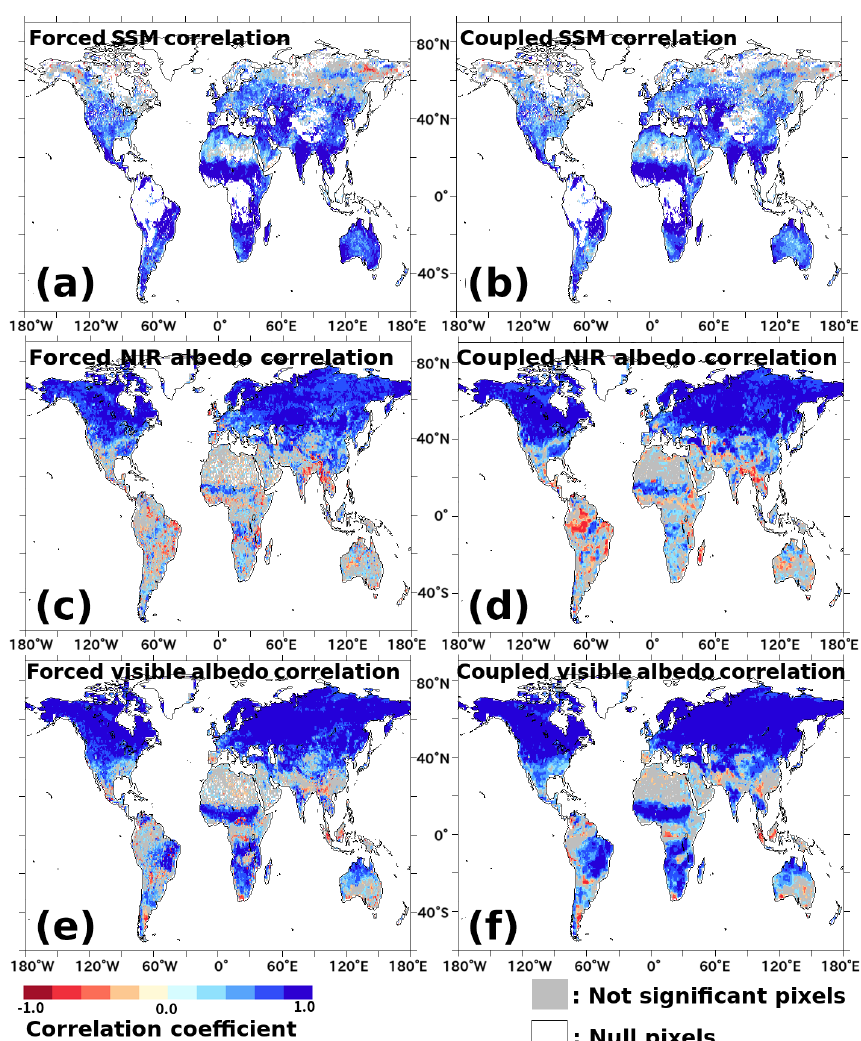
Figure 3. Spatial patterns of the correlation coefficient along time series (with monthly time steps) per pixel for SSM and albedo. (a, b) Cor- relation coefficient between simulated SSM and CCI-SSM in normalized VWC for forced and coupled mode, respectively. (c, d) Correlation coefficient between simulated and observed (MODIS) albedo in NIR band for forced and coupled mode, respectively. (e, f) Those in visible band. White areas are null pixels that were excluded by the quality control, and gray areas are statistically not significant